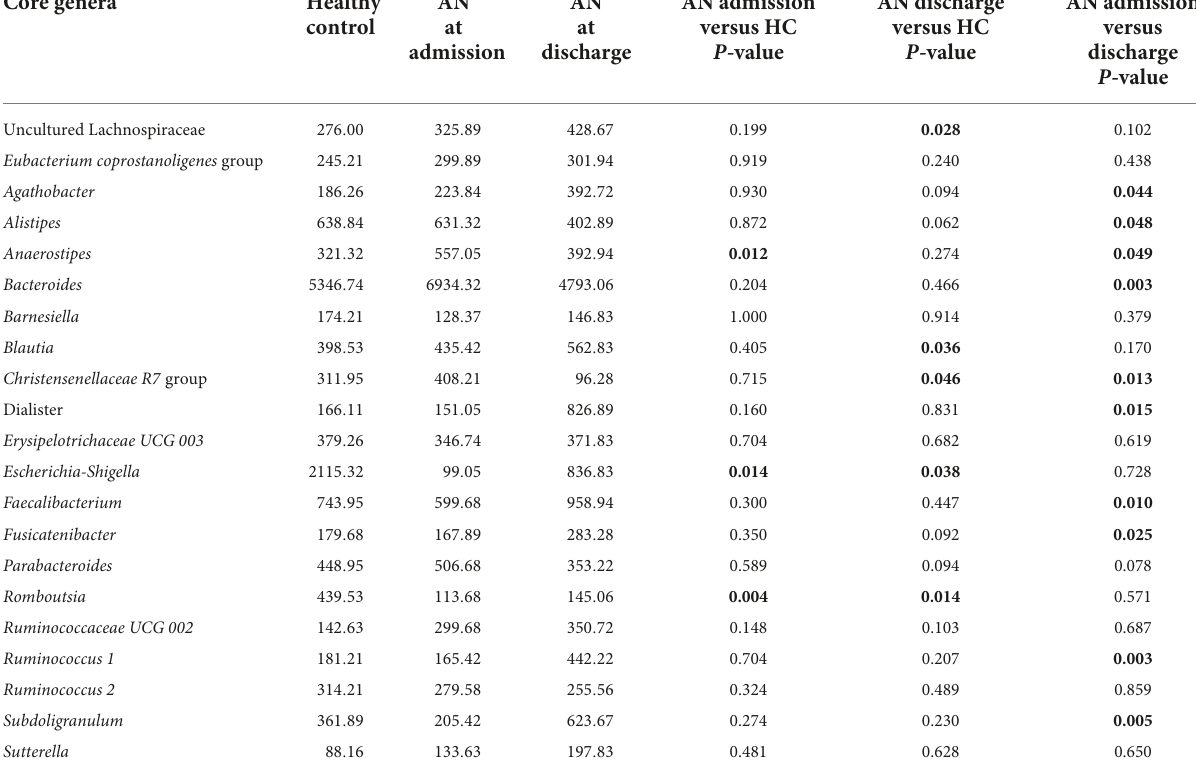
TABLE 2 Altered abundance of microbial